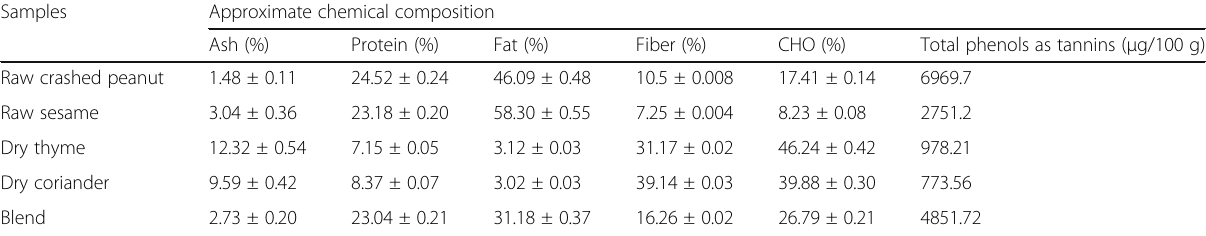
Table 2 Chemical composition and total phenols contents of ingredients and blend (mean ± SE) Samples